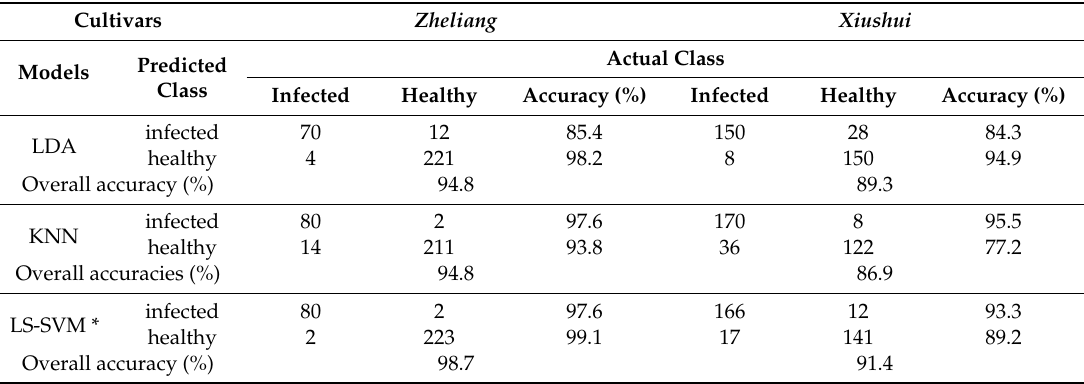
Table 2. Classification accuracies of rice seeds of Zheliang and Xiushui based on the spectral features from di ff erent classification